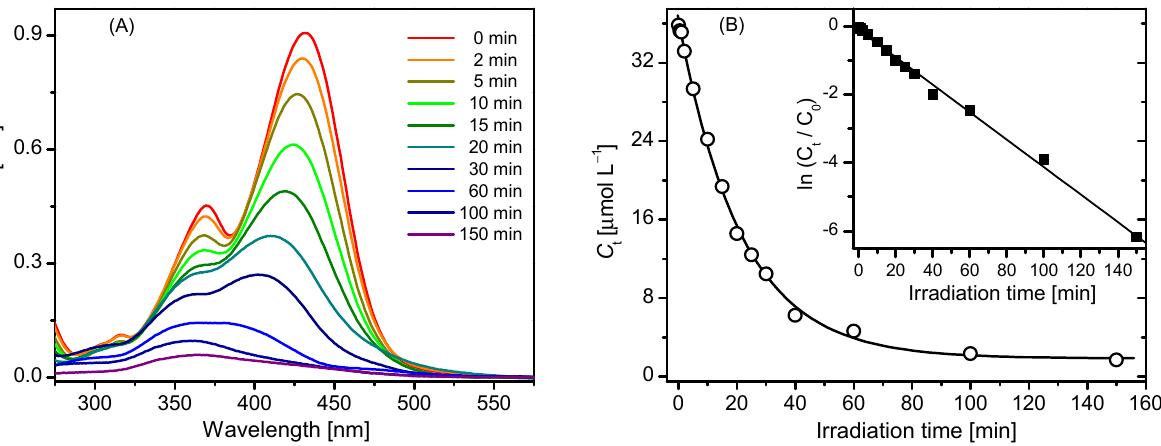
Figure 1. ( A ) Absorption spectra of AO (35.06 μ mol L ‒ 1 ) in an aqueous colloidal solution, in the presence of 5 mg TiO 2 NPs, after different irradiation times, as indicated; and ( B ) a plot of C t against AO as a function of irradiation time, simulated using the Langmuir–Hinshelwood kinetic model. Inset: the linear plot of ln ( C t / C 0 ) against irradiation time.